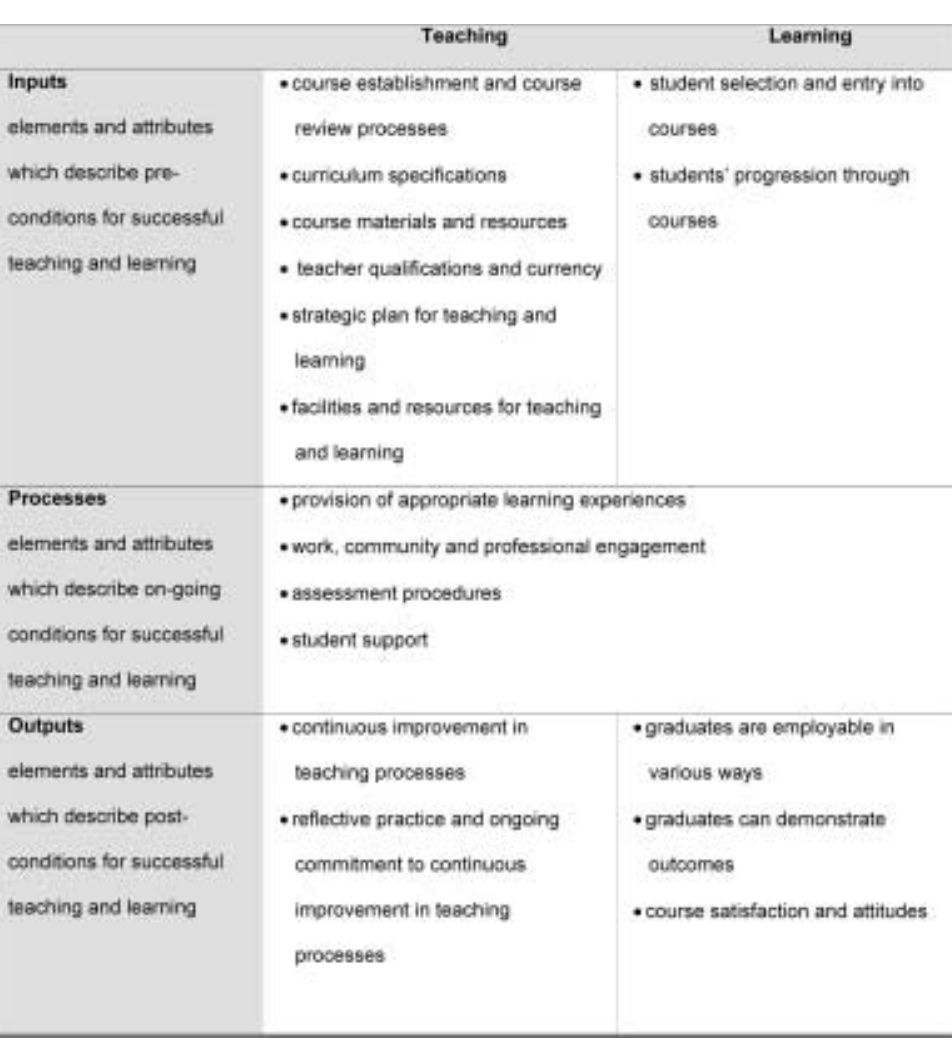
Figure 4. A framework describing quality teaching and learning (Oliver et al. ,